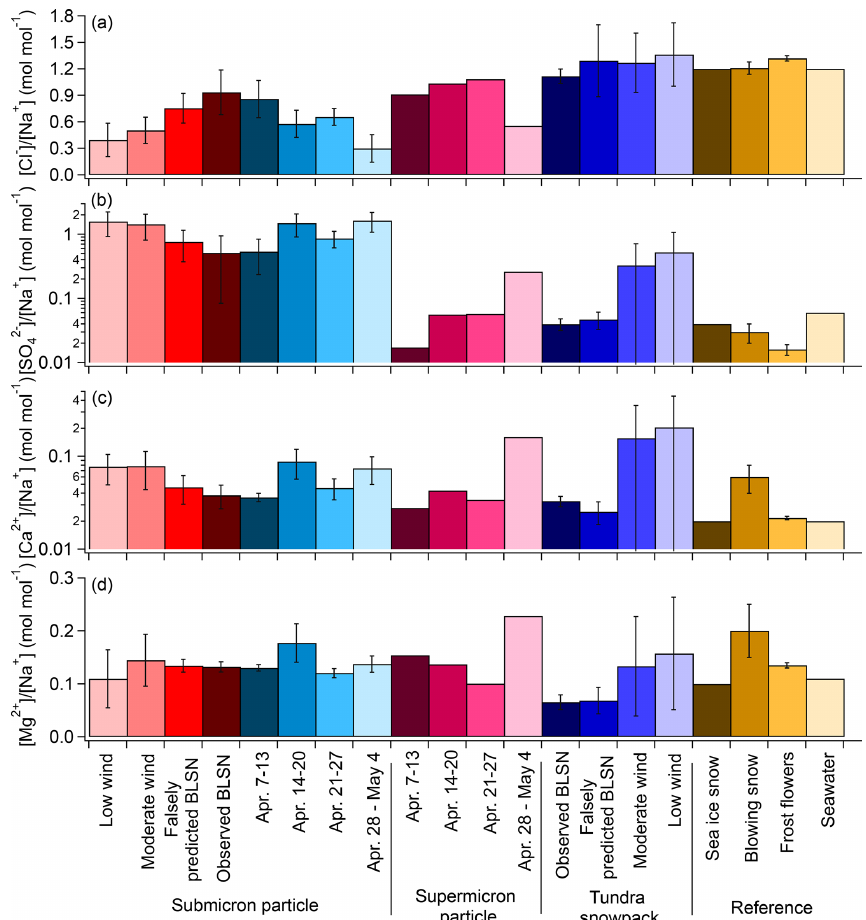
− ] / [Na + ], [Ca 2 + ][Na + ], and [Mg 2 + ] / [Na + ] molar ratios for submicron particles and Figure 5. Average ( ± 1 σ ) [Cl − ] / [Na + ], [SO 2 4 local tundra surface snowpack for the categories of low wind, moderate wind, falsely predicted BLSN, and observed BLSN periods and for multi-day supermicron particles collected on 7–13 April (65% observed BLSN, 35% falsely predicted BLSN), 14–20 April (9% observed BLSN, 29% falsely predicted BLSN, 58% moderate wind, 4% low wind), 21–27 April (3% observed BLSN, 23% falsely predicted BLSN, 47% moderate wind, 27% low wind), and 28 April–4 May (66% moderate wind, 34% low wind). The submicron particle ion ratios (average ± 1 σ ) during the four supermicron particle collection periods are shown for comparison. Comparison is also shown to previous